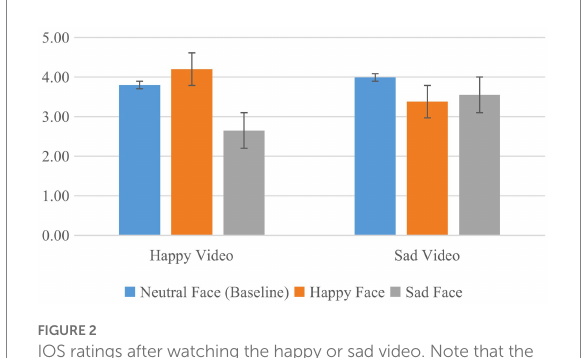
FIGURE 2 IOS ratings after watching the happy or sad video. Note that the analyses considered the differences between the happy face and sad face conditions to the neutral face